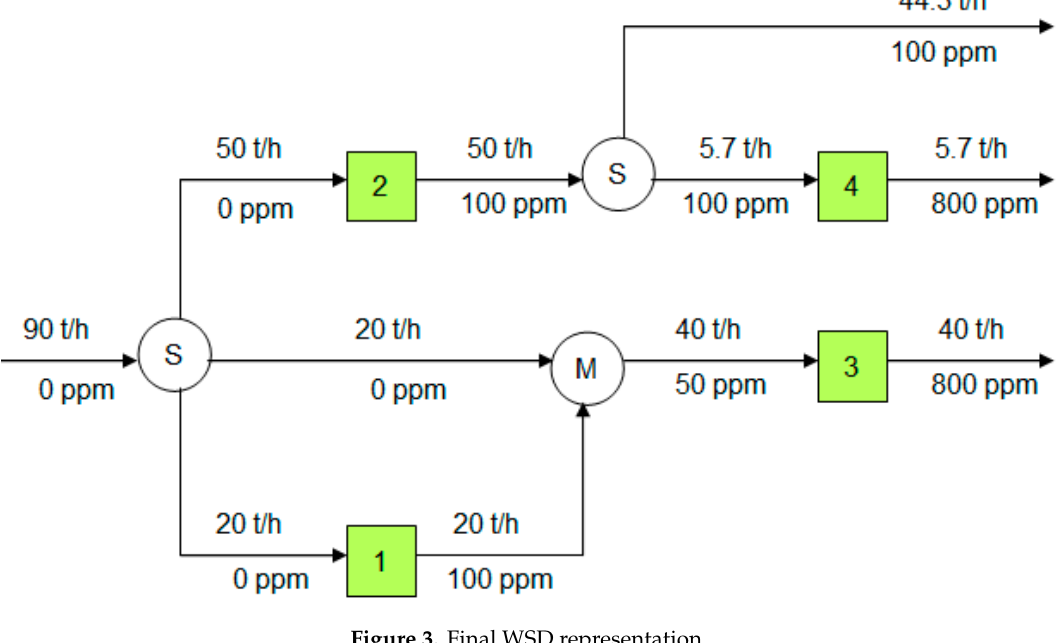
Figure 3. Final WSD representation.